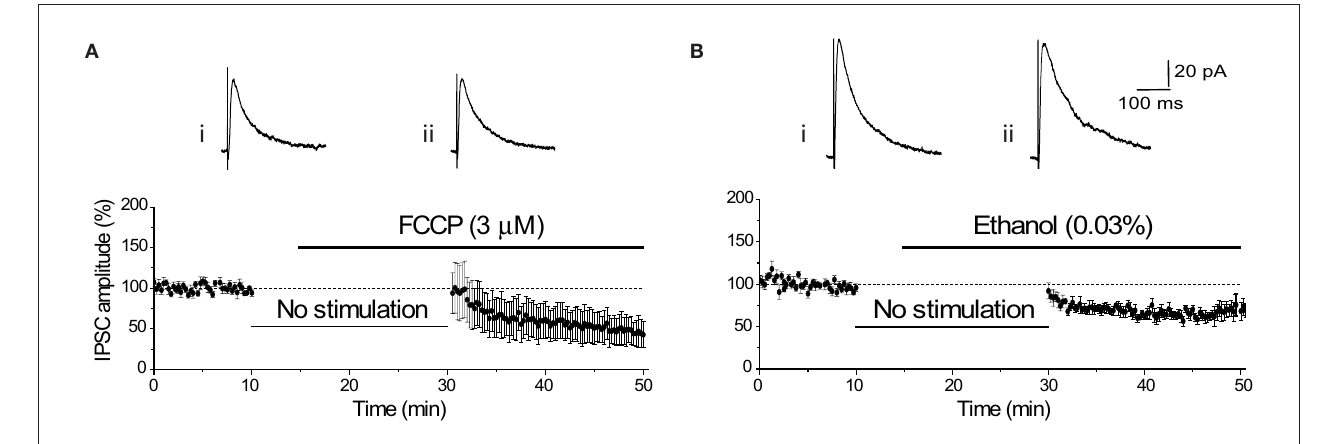
comparable with that seen under control conditions. (B) The diary plot shows that application of the vehicle control (0.03% ethanol) had no initial effect on the mean IPSC amplitude, with the mean IPSC amplitude gradually decreasing over the next 15 min of recording. Representative individual IPSCs from a single experiment show the final baseline response (i) and the first response evoked in ethanol (0.03%)